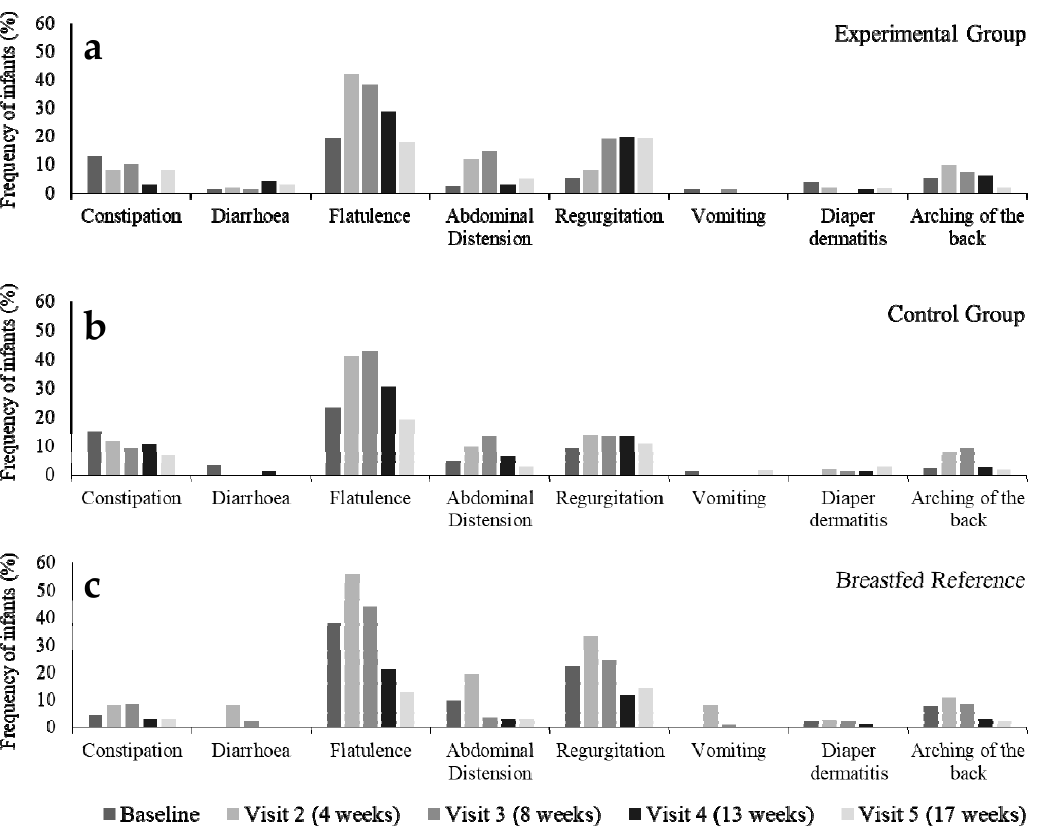
Figure 2. Parent-reported cumulative incidence of GI symptoms with a score of moderate or severe in healthy infants over time for ( a ) the experimental, ( b ) control and ( c ) breastfed reference group in the PP t population. PP t = Per protocol population for diary data on tolerance outcomes.